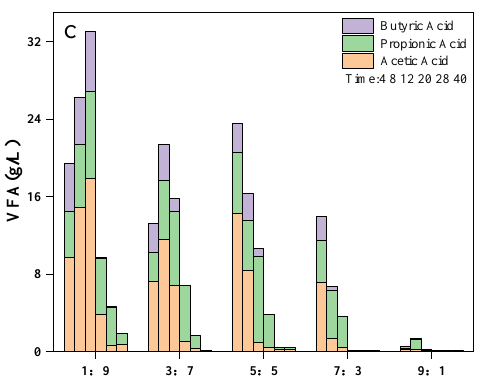
Figure 4. Change in volatile fatty acids (VFA) during the AD. Here, ( a ), 5% TS; ( b ), 10% TS and ( c ), 15% TS.